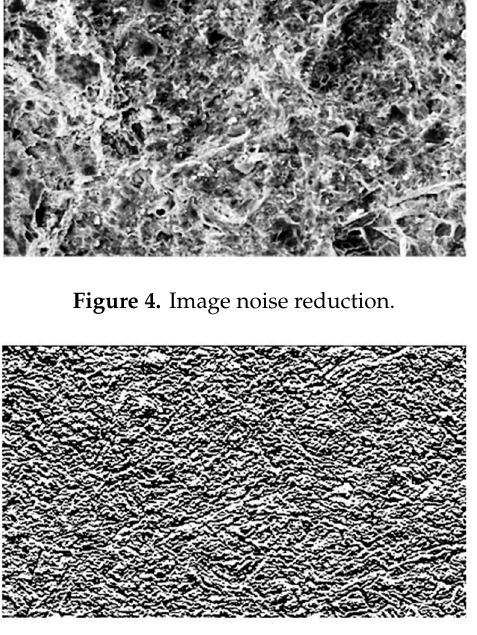
Figure 5. Image Figure 5. Image sharpening. Figure 5. Image sharpening.